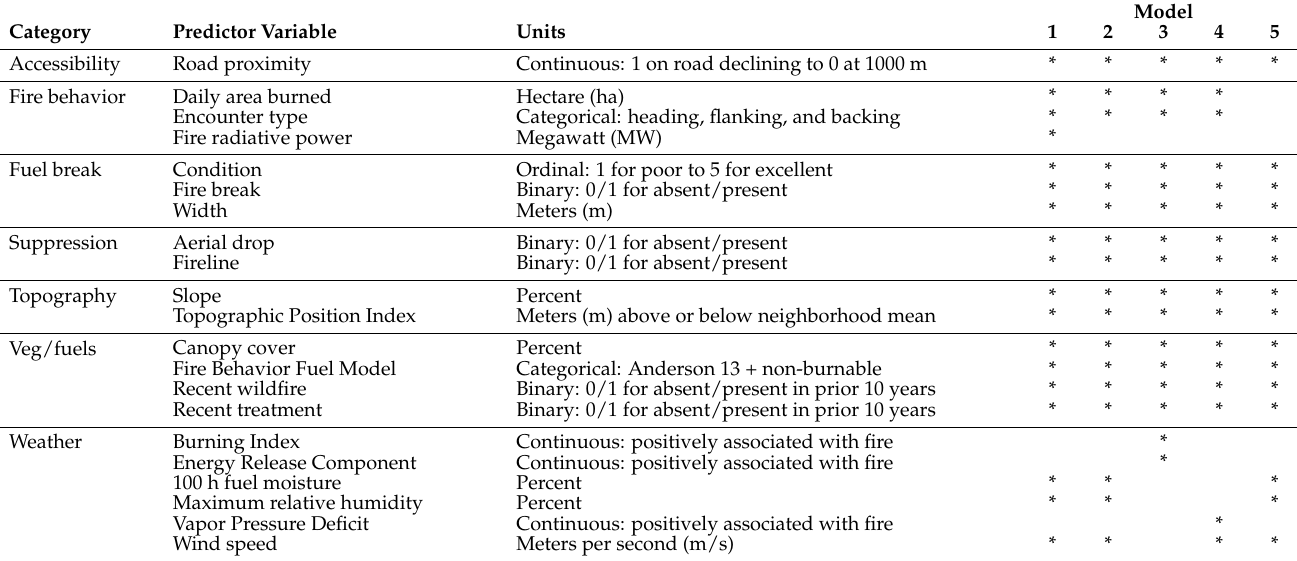
Table 2. Predictors of fuel break effectiveness sorted by data category (see text for complete descriptions and data sources) and specification of models evaluated in this paper (* for inclusion in